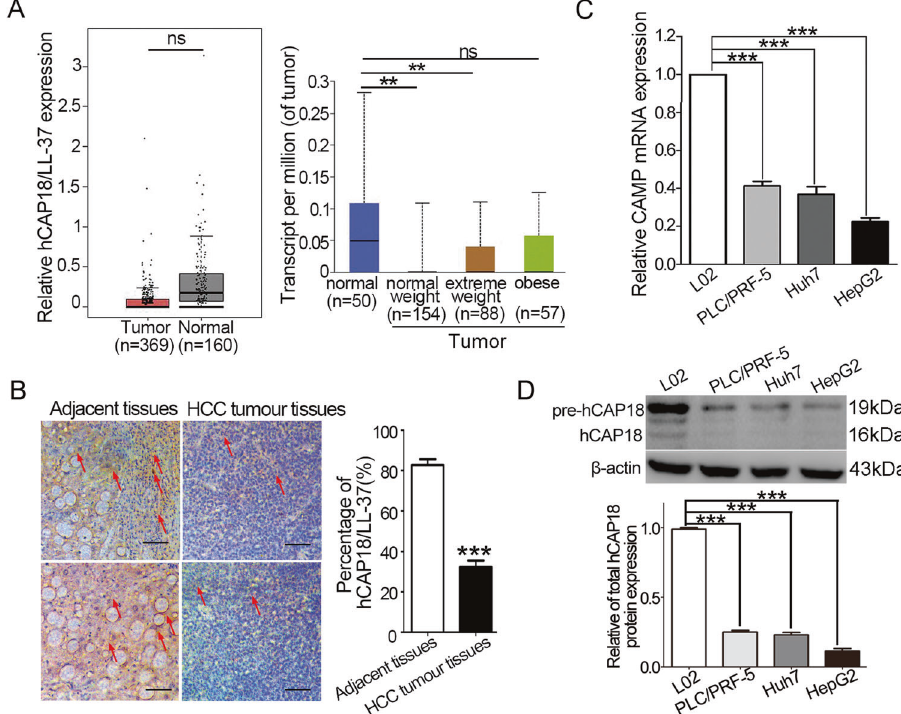
Fig. 1 hCAP18/LL-37 expression levels in HCC tumors and cell lines. A CAMP mRNA levels in HCC tumor and normal liver tissues based on GEPIA and UALCAN databases. B Immunohistochemistry (IHC) shows the percentage of hCAP18/LL-37 — positive cells ( n = 60). Representative images of IHC staining analysis of hCAP18/LL-37 expression in HCC tissues and adjacent non-tumor tissues. The arrows indicate the hCAP18/ LL-37 positive cells. Original magni fi cation, ×200. Scale bars = 50 μ m. C CAMP mRNA levels in HCC and normal L02 cells were detected by qRT- PCR. D pre-hCAP18 and hCAP18 levels in HCC and L02 cells were detected by western blotting using hCAP18/LL-37 antibody. Relative protein expression of total hCAP18 (per-hCAP18 and hCAP18) vs. β -actin was determined using ImageJ densitometry analysis. ** p < 0.01, *** p < 0.001, and ns (no signi fi